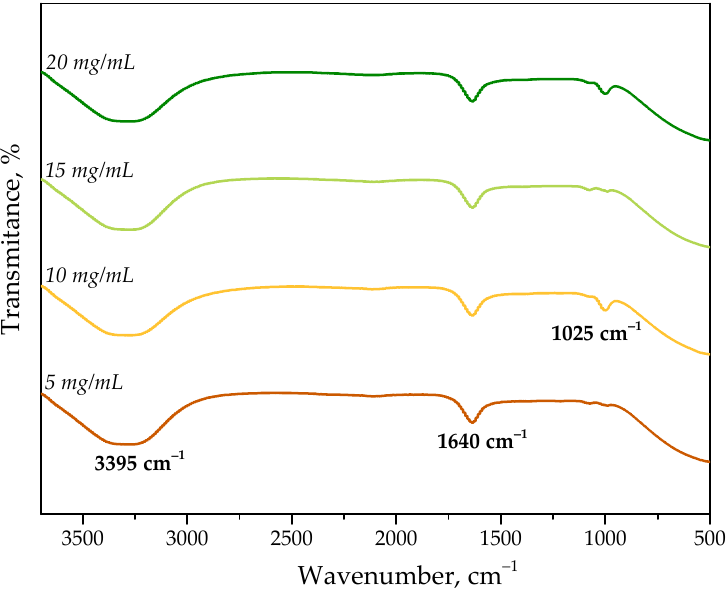
Figure 2. FT-IR spectra of protein particles suspensions obtained using various concentration of albumin solution.